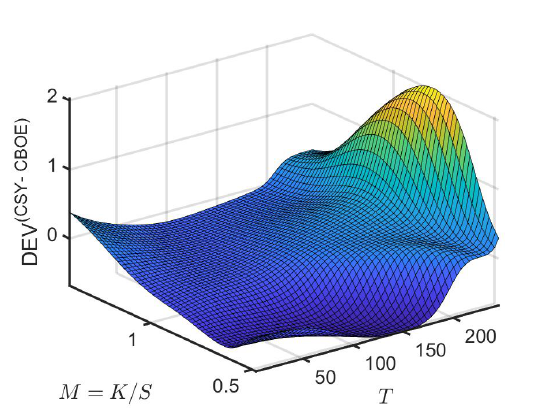
Figure 8. Relative volatility deviation against time to maturity T and moneyness M = K / S